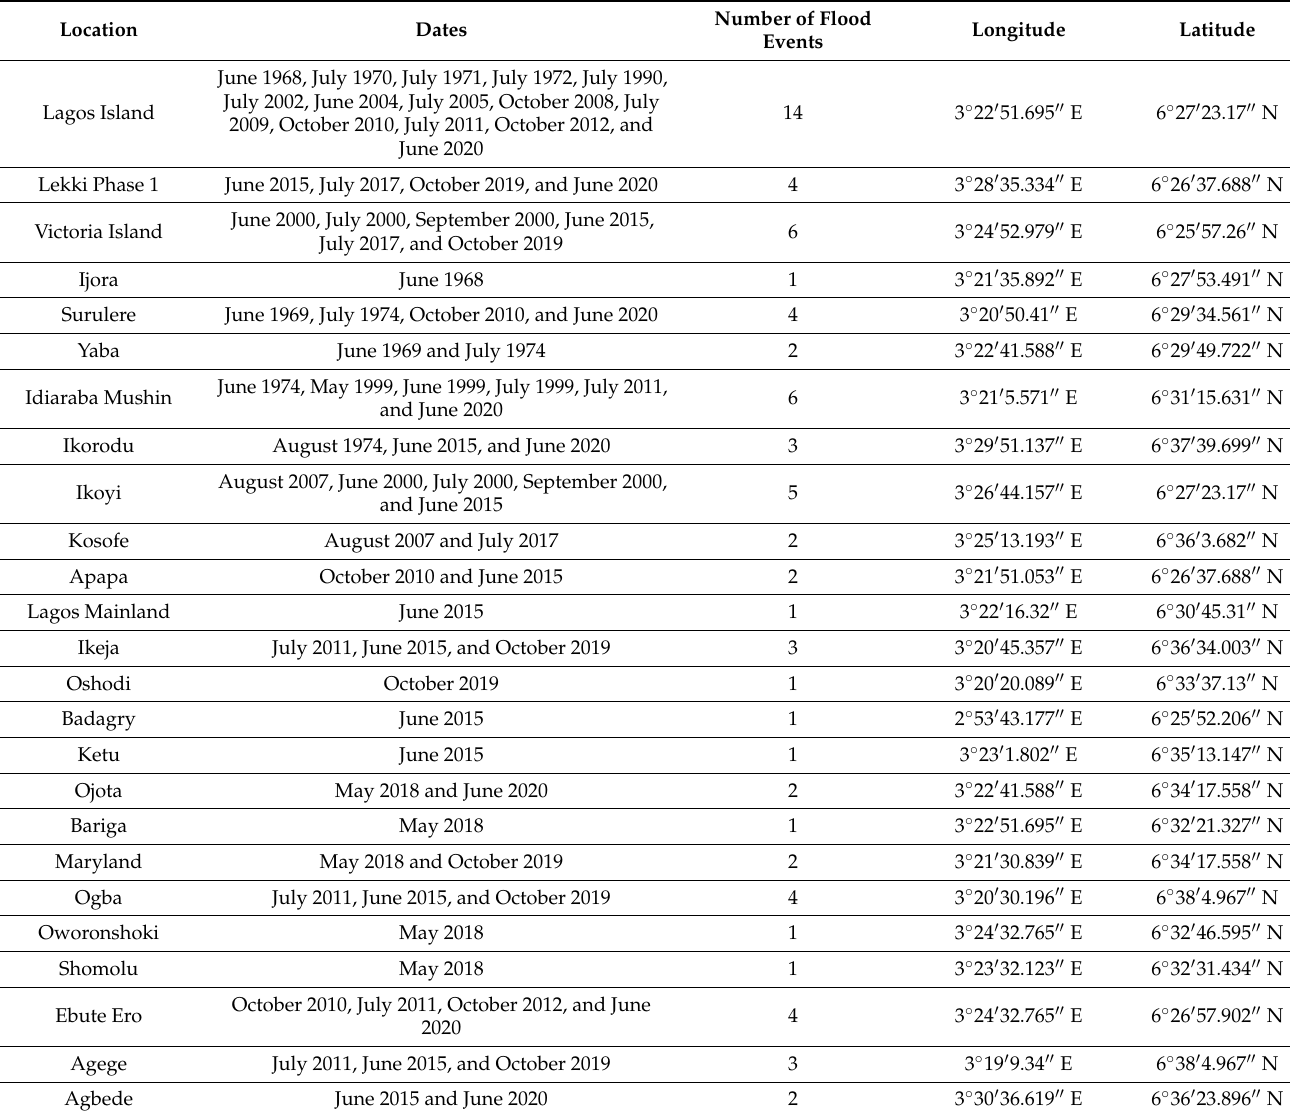
Table 3. List of recorded flood events in various locations within Lagos State from 1968 to 2020 compiled based on literature [19] and online news sources (e.g., Aljazeera, Arise News, GistNigeria by Channels, and Floodlist). Location Dates